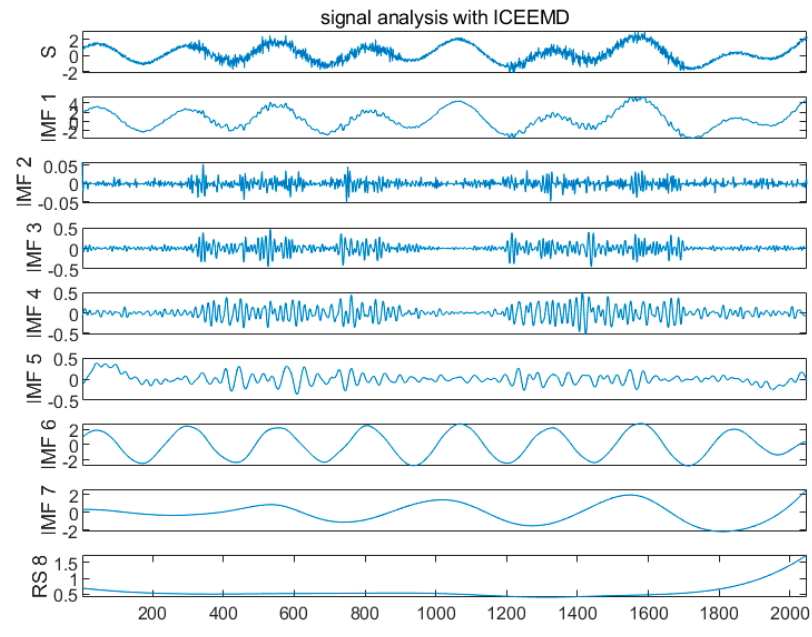
Figure 3. Seven sub-signals decomposed by ICEEMD.